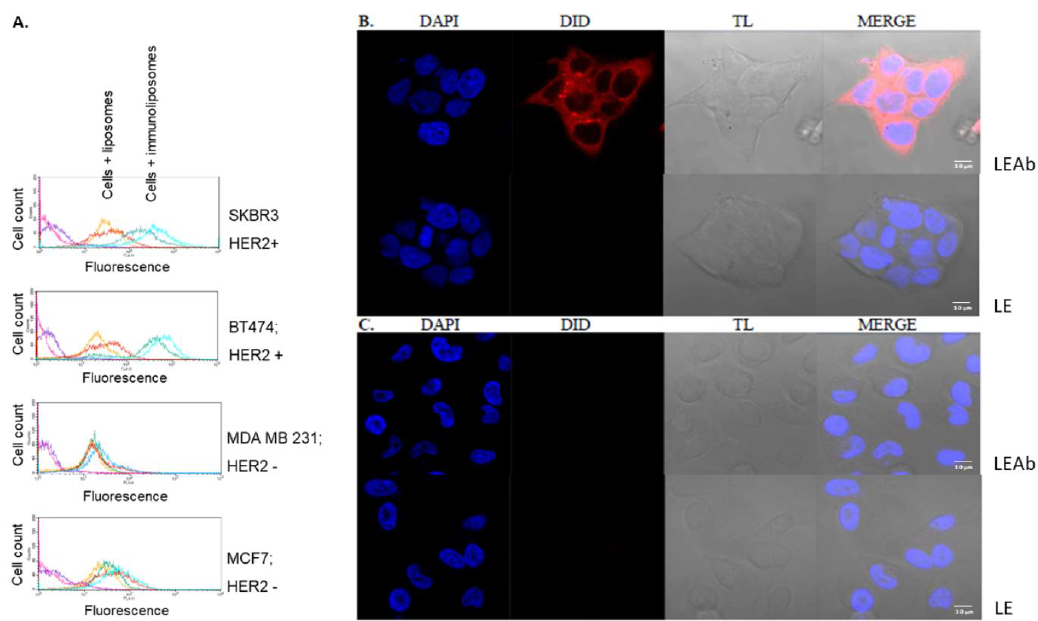
Figure 6. Selectivity of immunoliposomes interactions with different breast cancer cell lines. ( A ) Histograms for BT474, SKBR3, MCF7 and MDA MB 231 cells that were incubated with DiD(1,1’-dioctadecyl-3,3,3’,3’-tetramethylindodicarbocyanine)-labelled non-targeted liposomes or with DiD-labelled immunoliposomes for 30 min and 2 h. For BT474 and SKBR3 cell lines there is a significant shift to the right of the signal that is correlated with cells treated with DiD-labelled immunoliposomes (green line—30 min treatment, blue line—2 h treatment) in comparison to the signal obtained for cells treated with DiD-labelled non-targeted liposomes (yellow line—30 min, red line—2 h treatment). The shift of the signal was not observed for control cell lines. ( B ) Exemplary confocal images of BT474 breast cancer cells after 30 min of incubation with DiD-labelled immunoliposomes (top) and DiD-labelled non-targeted liposomes (bottom). ( C ) Exemplary confocal images of MDA MB 231 breast cancer cells after 30 min of incubation with DiD-labelled immunoliposomes (top) and DiD-labelled liposomes without antibodies (bottom). TL—transmitted light. Scale bar: 10 µ m. Blue: nuclei stained with DAPI; Red: DiD-labelled immunoliposomes.